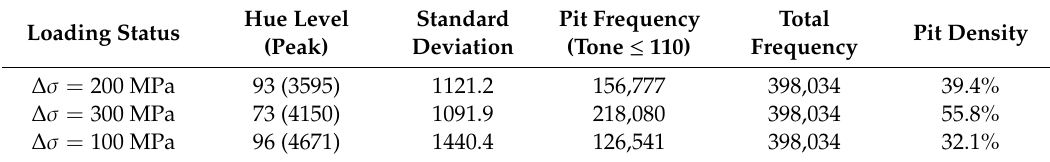
Table 3. Grayscale histogram data under the loading condition.